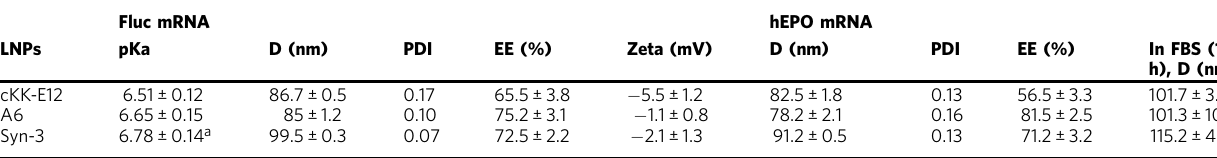
Table 2 Characterization of LNP